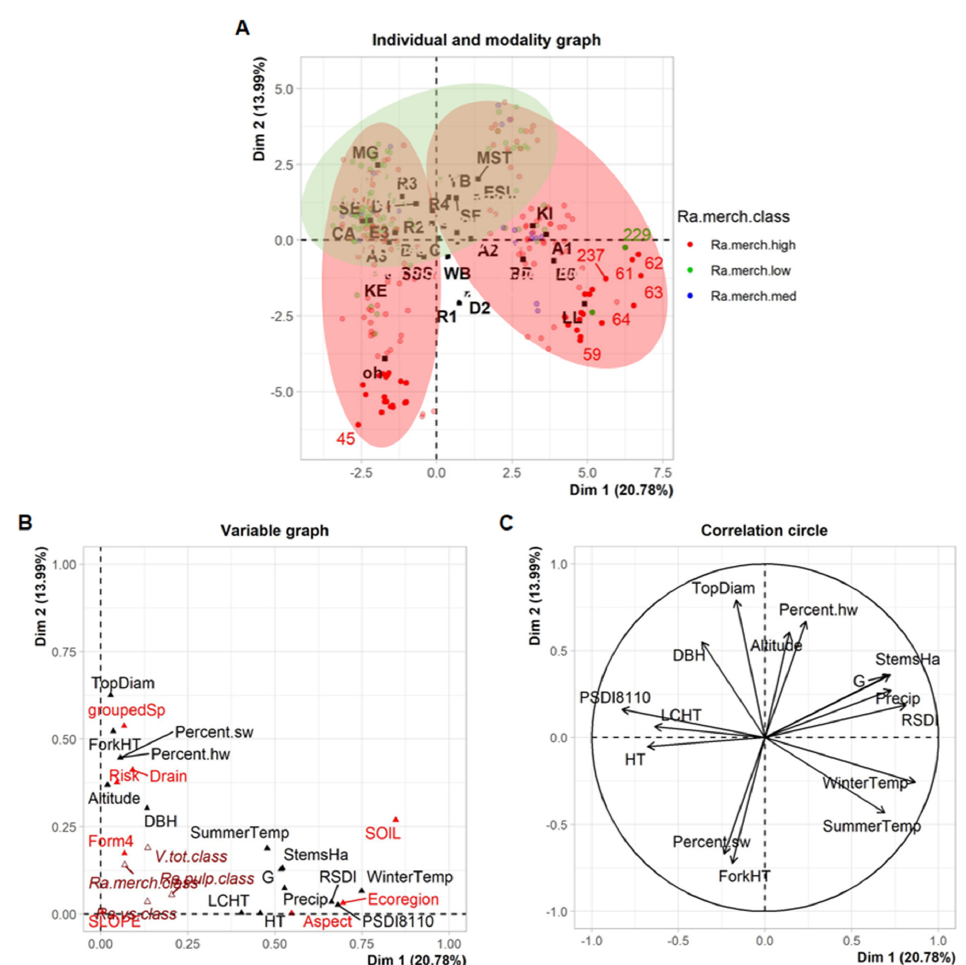
Figure 12. Individuals and modality graph ( A ), variable graph ( B ), and correlation circle ( C ) of FAMD on 302 trees bearing products having environmental data. In graphic A, only individuals and modalities with a contribution of greater than or equal to 0.5 are labeled, coloration depending on merchantable/total volume ratio.